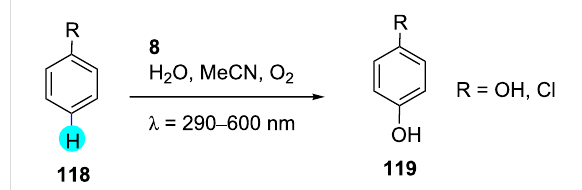
Aryl C–H hydroxylation: synthesis of substituted